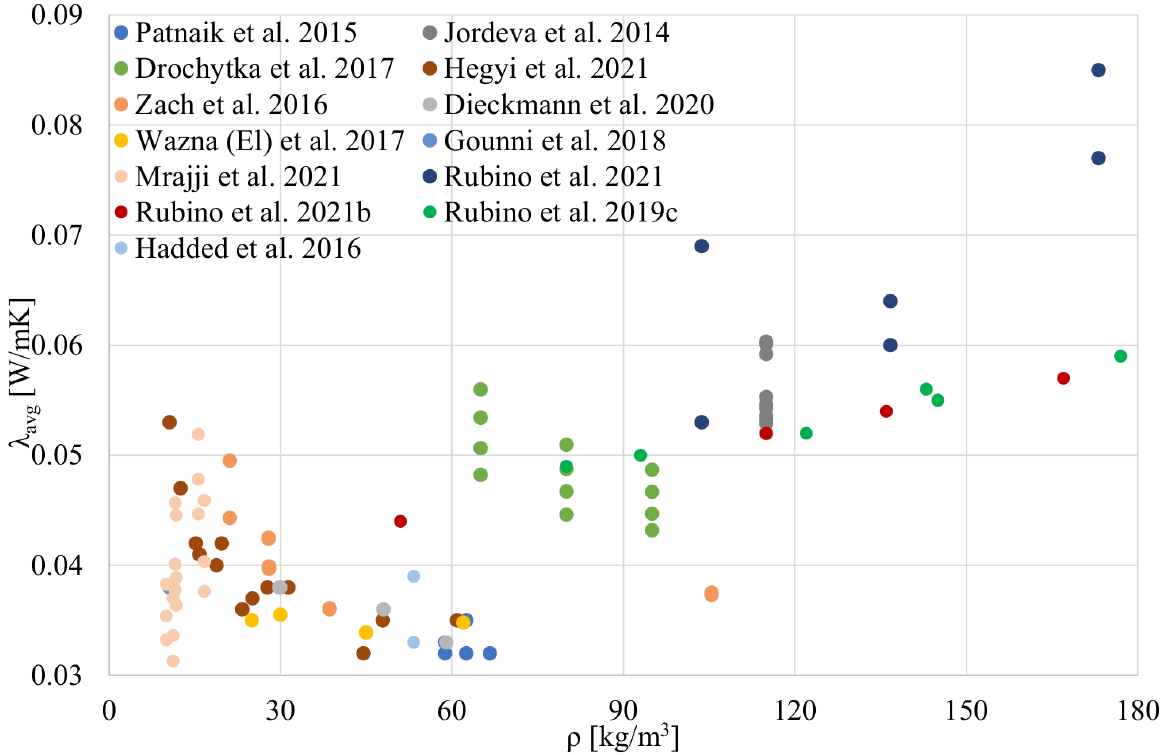
Figure 1. Thermal conductivity of textile wastes from